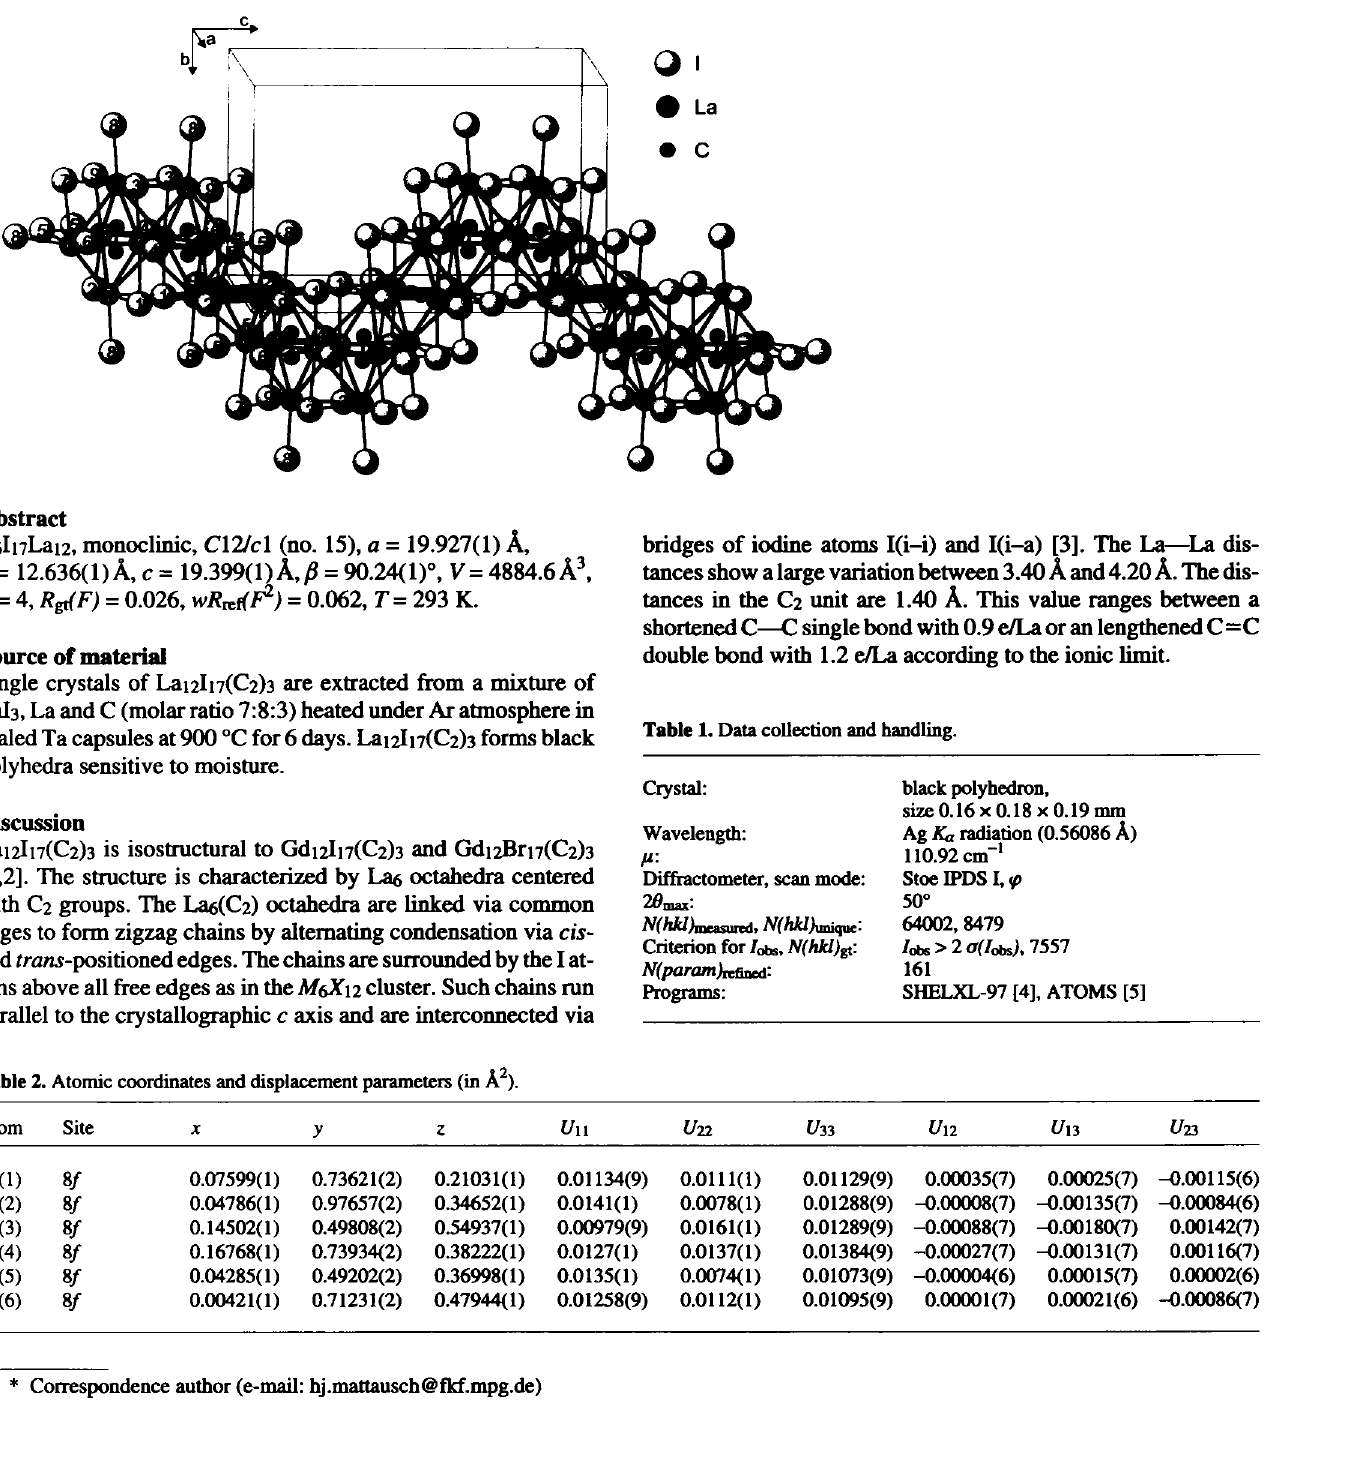
Table 2. Atomic coordinates and displacement parameters (in A 2